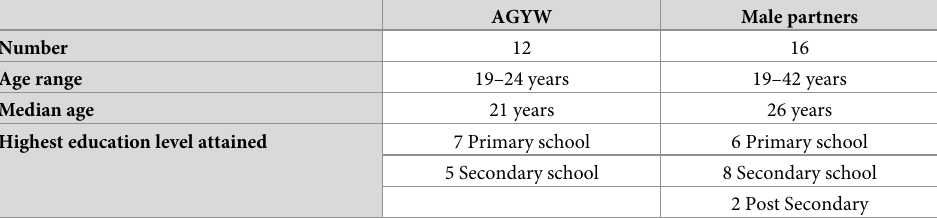
Table 2. Respondents’ socio-demographic